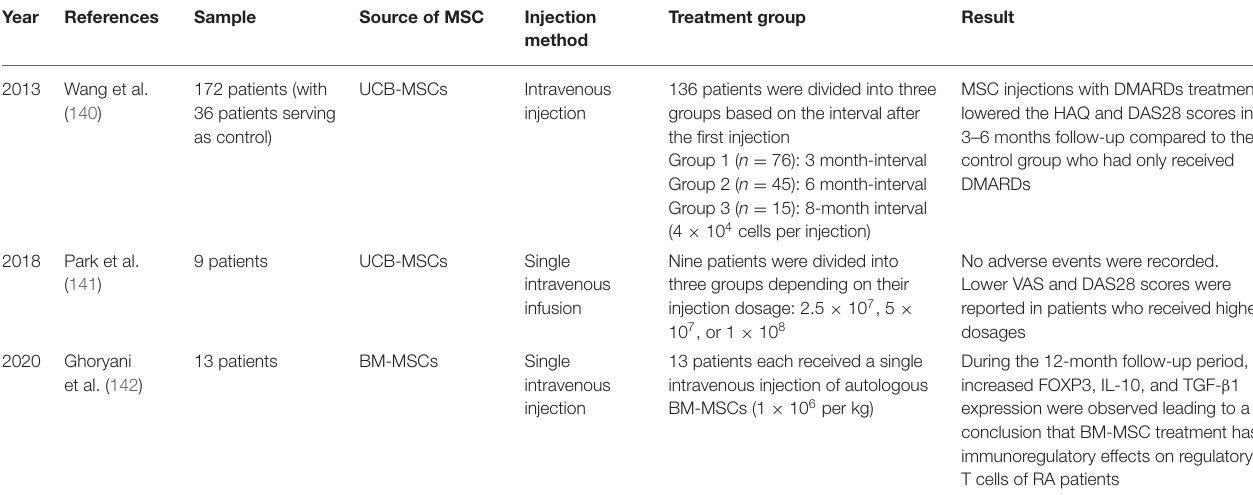
TABLE 3 | Clinical trials using MSCs in